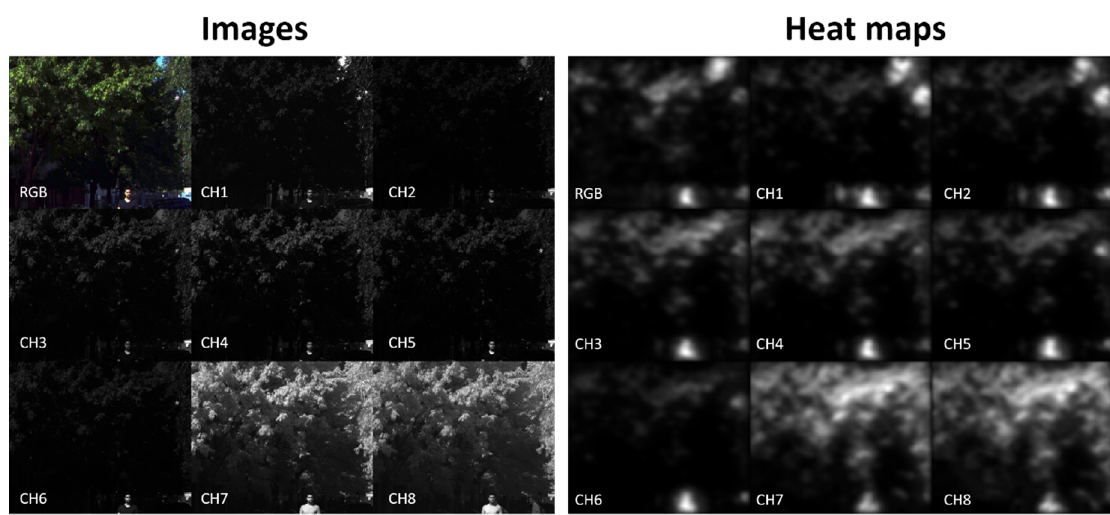
Figure 8. ( Left ) Example images fed to the RARE saliency prediction model. ( Right ) Heat maps generated for those images. RGB stands for the color image, and CHX for channel X of the multispectral image.